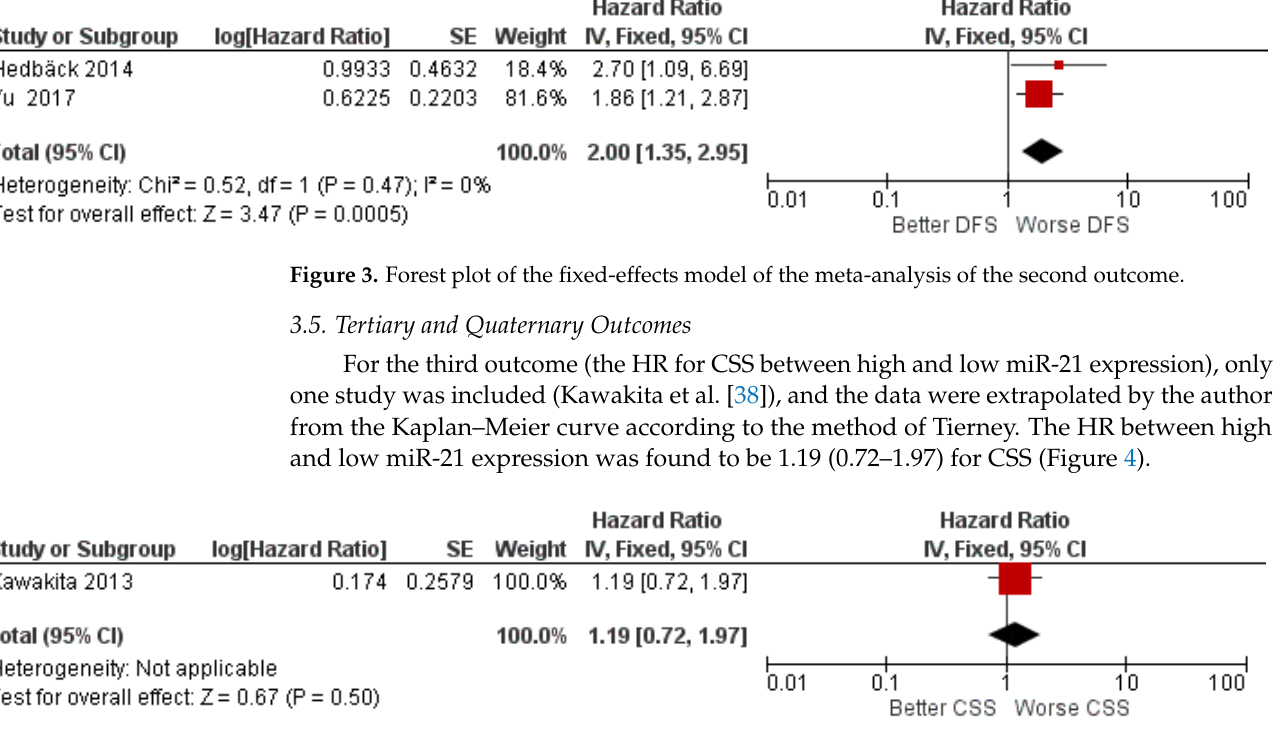
Figure 4. Forest plot of the fixed-effects model of the meta-analysis of the third outcome.